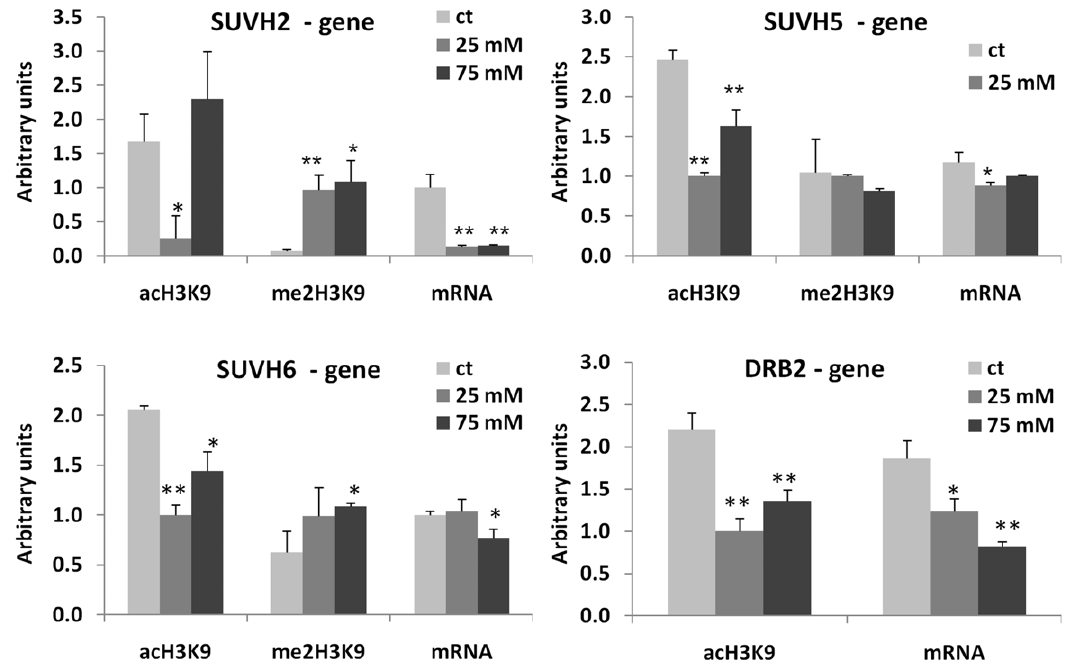
Figure 6. Histone modifications (H3K9me2 and H3K9ac) at the gene body regions of SUVH2 , SUVH5 , SUVH6 and DRB2 genes. The figure shows the levels of H3K9me2 and H3K9ac found at the gene body regions of SUVH2 , SUVH5 , SUVH6 and DRB2 genes. Each figure also shows mRNA levels for each of the genes. The Y-axis shows the levels of mRNA expression and H3K9me2/H3K9ac in average arbitrary units (calculated from three independent experiments with SD). The asterisks denote a significant difference between the progeny of stressed (25 and 75 mM) and control plants; one asterisk stands for p , 0.05 and two asterisks for p , 0.01.